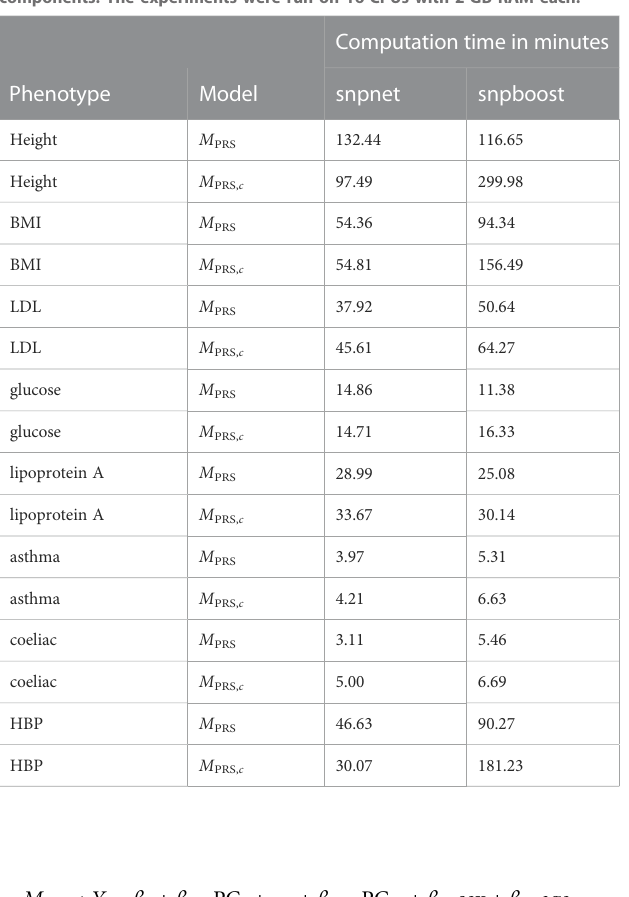
TABLE 2 Comparison of computational ef fi ciency of snpnet and snpboost on eight phenotypes from the UKBB. Computational times of the algorithms snpnet and snpboost for multivariable polygenic models with and without inclusion of the covariates for the prediction of eight phenotypes from the UKBB. M PRS corresponds to the application of the algorithms without including covariates and M PRS, c to the inclusion of the covariates sex, age and the fi rst ten principal components. The experiments were run on 16 CPUs with 2 GB RAM